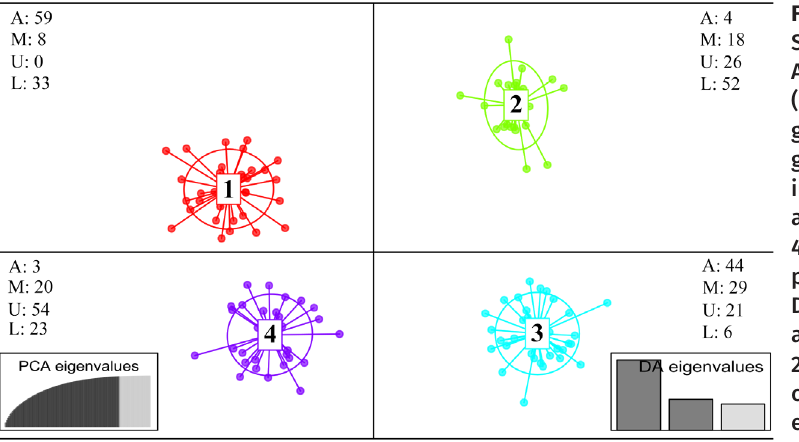
Figure 2. Genetic clustering. Scatterplot of the Discriminant Analysis of Principal Components (DAPC) depicting relative intra- group and amongst-group genetic distances. Dots represent individual samples and centroids are indicated with numbers (1- 4). Inset indicates the number of principal components retained by DAPC and the cumulative variation among these (55.76%, 23.72% and 20.51%, respectively). The relative contribution of individuals from each site (A, M, U and L; see Table I) to the corresponding genetic cluster (1-4), is expressed in